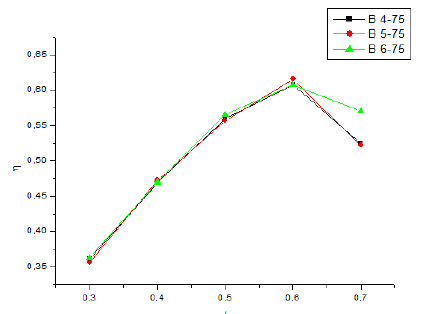
Fig. 5 .Blade number effect on the propeller efficiency